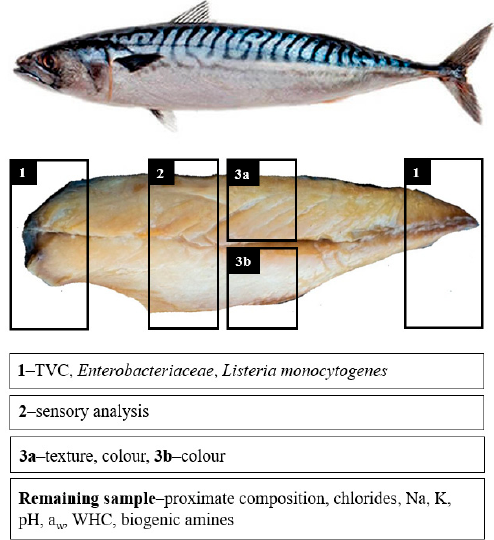
Figure 2. Smoked mackerel sampling for